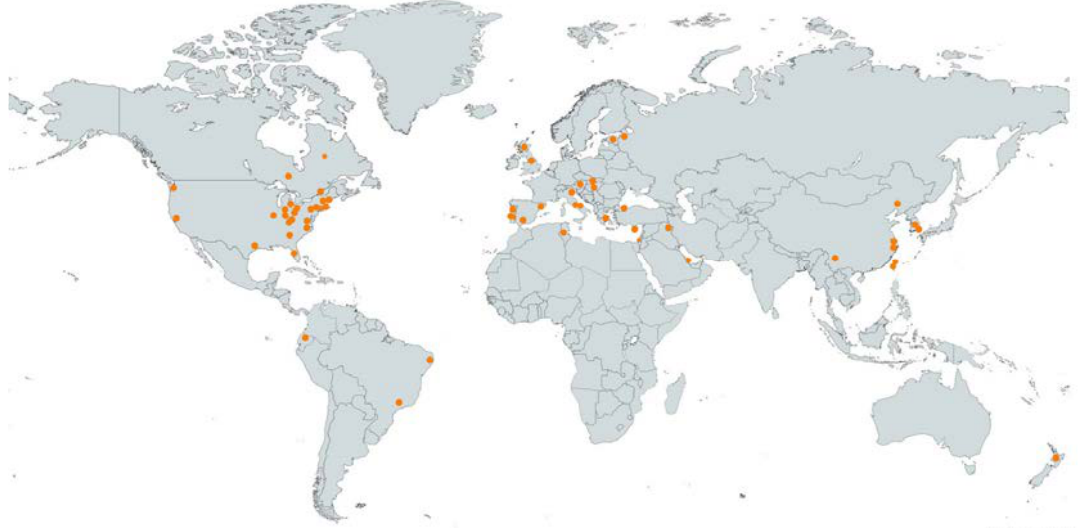
Fig. 3: Geographical distribution of case studies. Every orange dot represents a location.